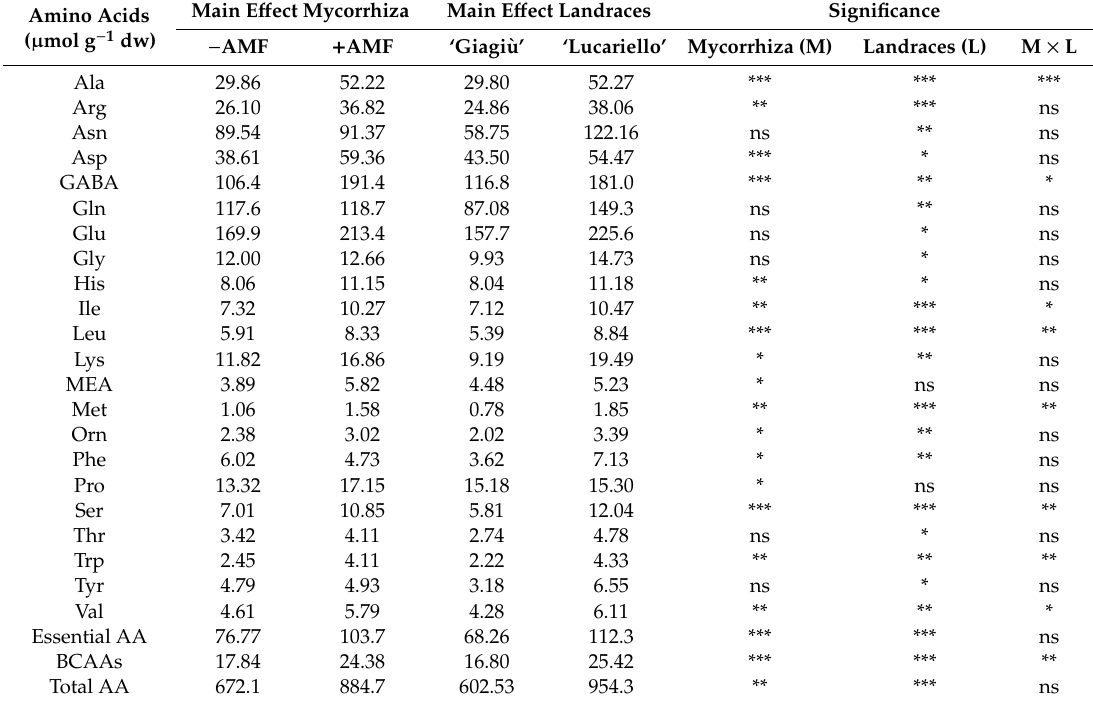
Table 4. Significance of the main e ff ects and their interactions on free amino acids profile and total amino acids content. Values represent means of three